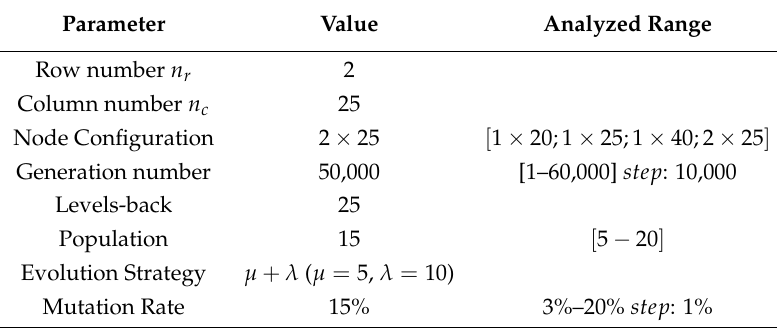
Table 2. CGP Parameters